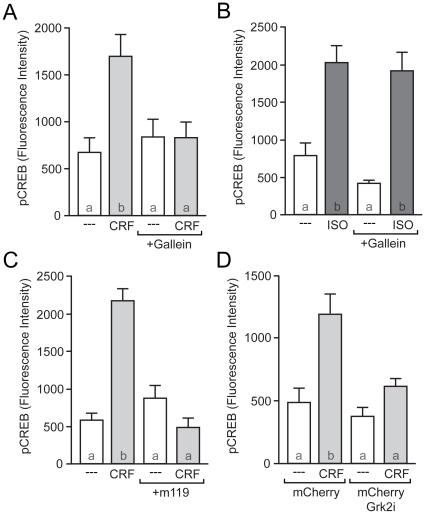
CRF-induced CREB phosphorylation occurs via a Gβγ-dependent mechanism.(A) The Gβγ-specific blocker gallein (75 µM) eliminated CRF-induced CREB phosphorylation (F = 6.13). (B) In contrast, gallein had no effect on CREB phosphorylation induced by the β-adrenergic receptor agonist, isoproterenol (F = 16.83). (C) An additional Gβγ blocker (M119; 5 µM) also eliminated CRF-induced CREB phosphorylation (F = 27.96). (D) Neurons transfected mCherry and the Gβγ inhibitory peptide Grk2i failed to exhibit CRF-induced CREB phosphorylation (F = 11.26).